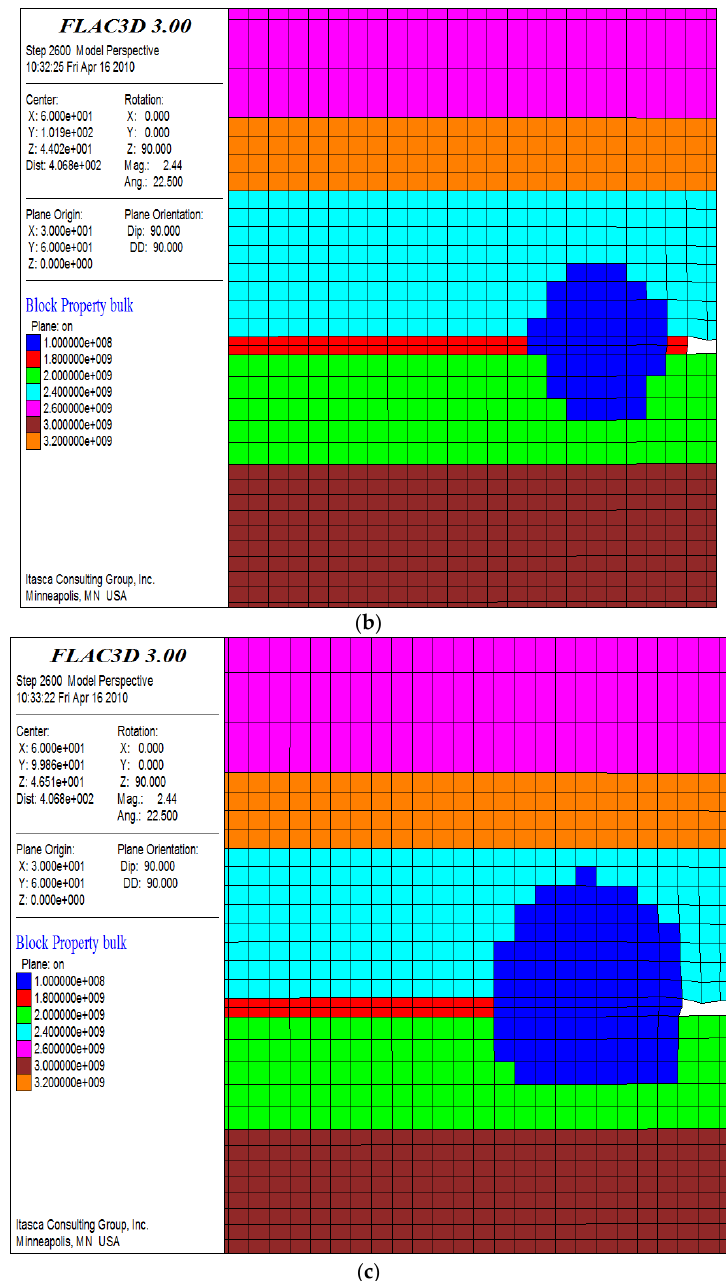
Figure 11. Simulation of water affected area under three different conditions: ( a ) Borehole length 40 m, diameter 50 mm; ( b ) Borehole length 50 m, diameter 55 mm; ( c ) Borehole length 60 m, diameter 60 mm.